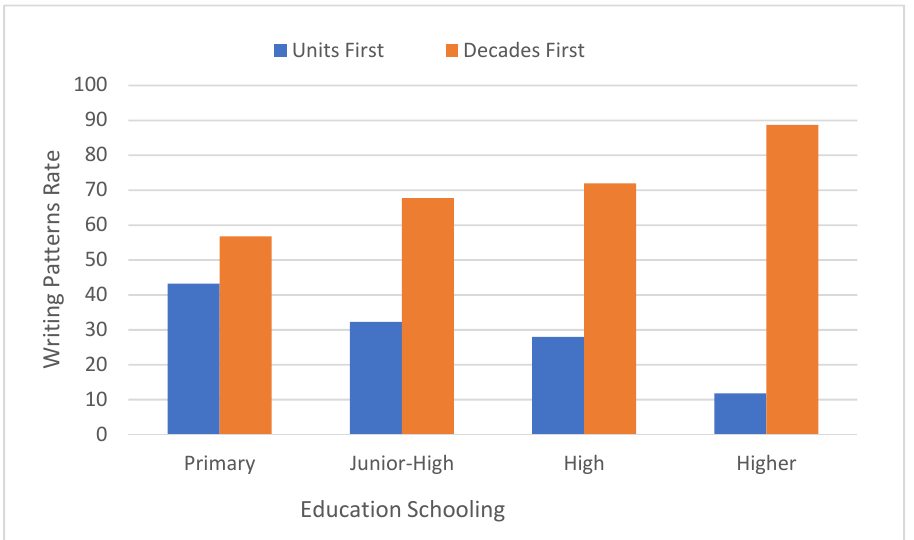
Figure 2. The units first (right to left) and decades first (left to right) writing pattern rates as a function of educational level (primary, junior-high, high, higher).